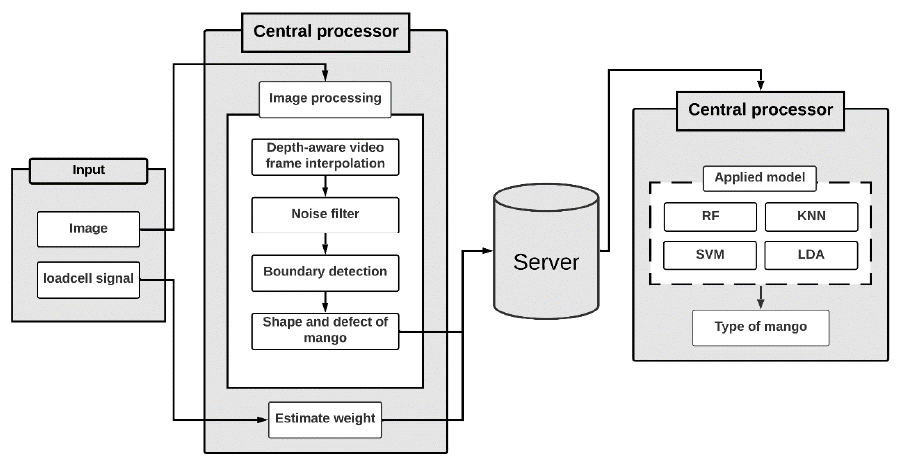
Figure 4. Operating procedures of the system.